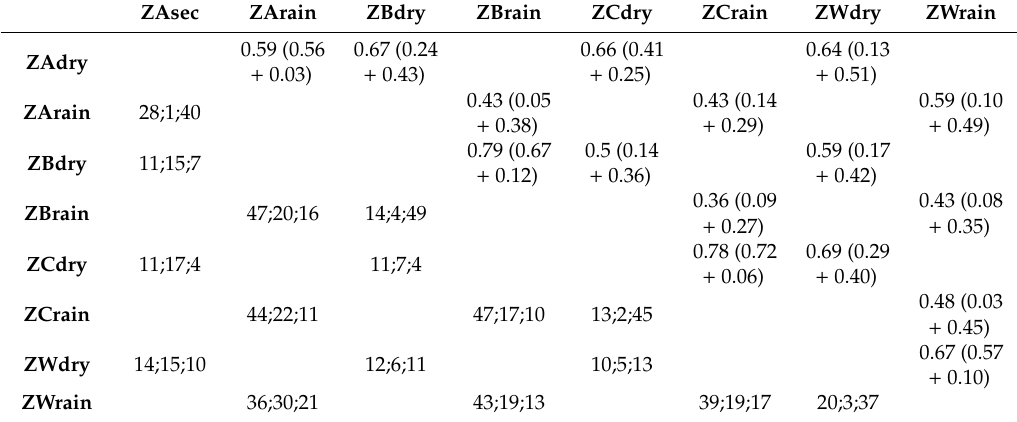
Table 2. β -diversity values between sites (ZA to ZW: Zone A, B, C and W; see Material and Methods / Study sites for more details) and between seasons (see Material and Methods for calculations). Above diagonal calculated values [ β cc ( β rich + β − 3)], below diagonal, “a,b,c” values (see Material and Methods); a is the number of species common to both sites, b is the number of species exclusive to the first site, and c is the number of species exclusive to the second